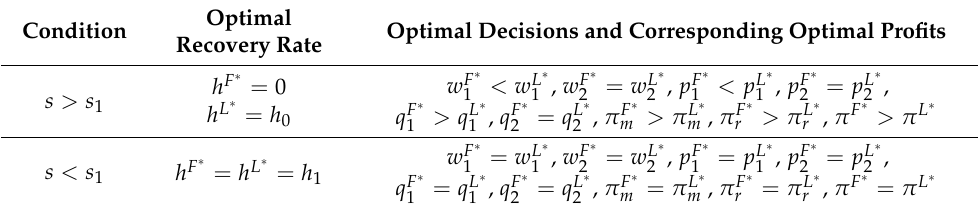
Table 4. Comparison of optimal decisions and optimal profits of two models. Optimal Condition Recovery